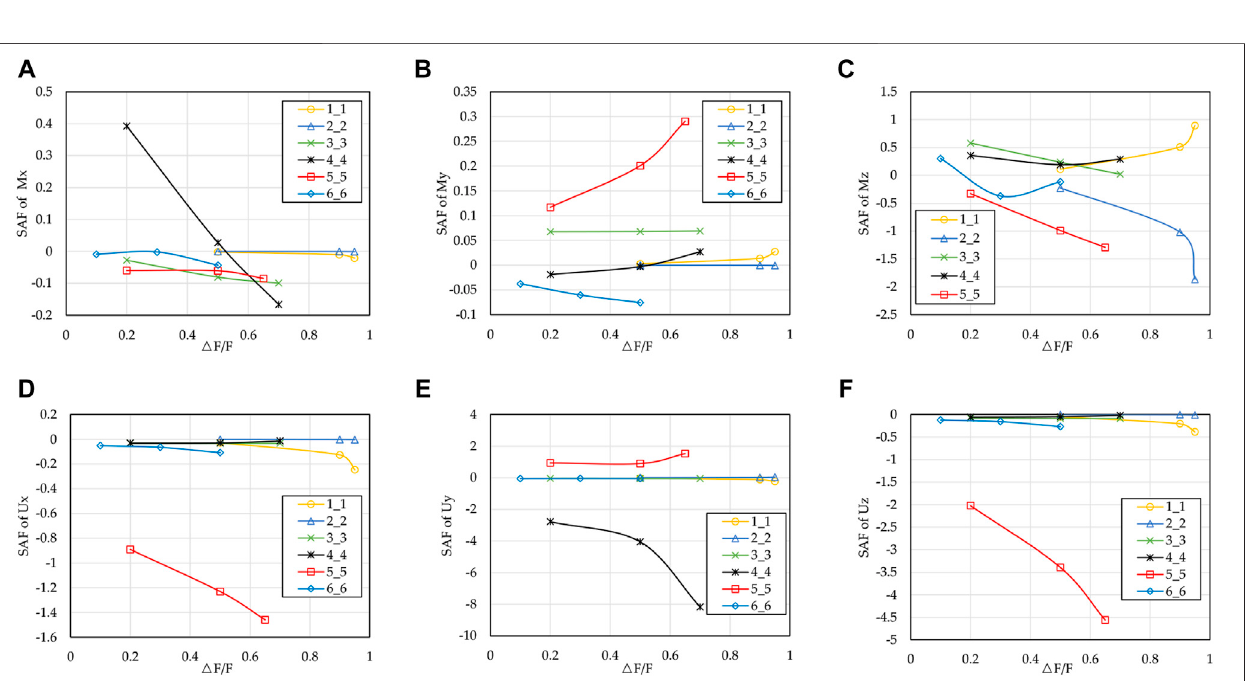
FIGURE 9 | In fl uence of main diagonal stiffness coef fi cient on medium and high sensitivity.